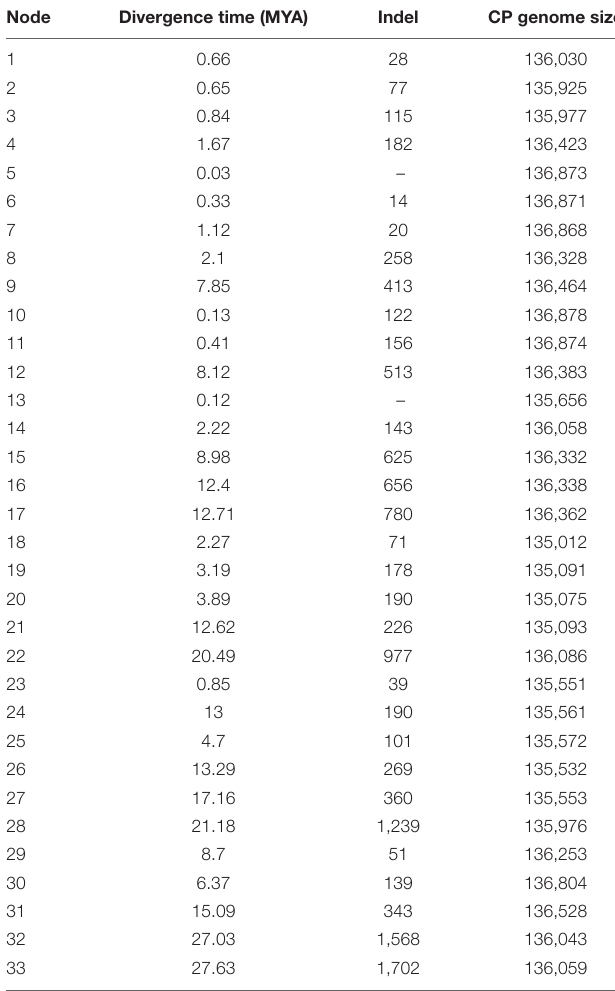
TABLE 3 | Divergence time and indels in every node of 34 Triticeae species in the phylogenomic tree. Node Divergence time (MYA)